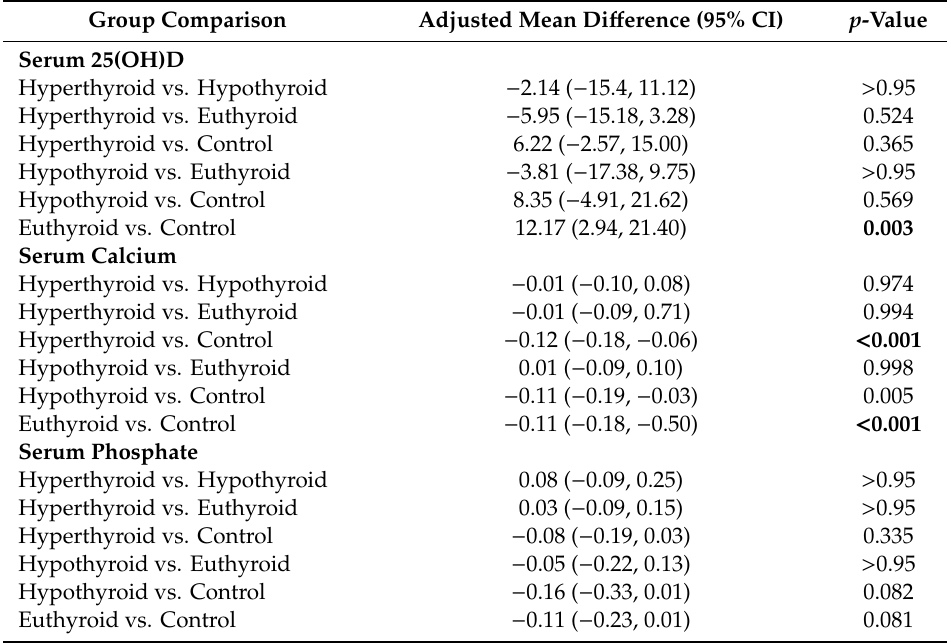
Table 5. Post hoc pairwise comparison of ANOVA analysis for mean serum 25(OH)D, serum calcium, serum phosphate in between group, using Games–Howell method.